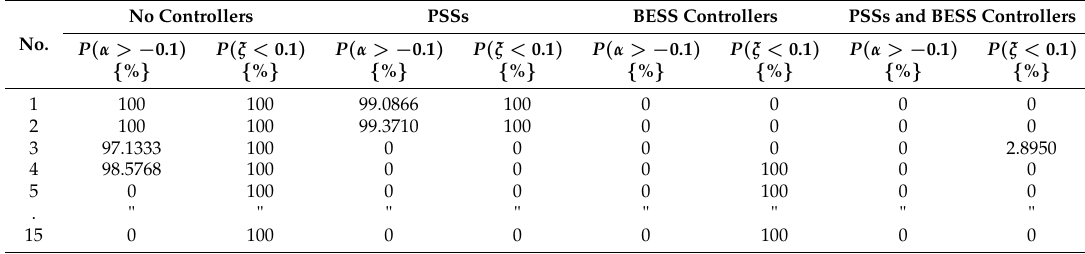
Table 10. Stability indices under different controller conditions for Scenario 2 using OBTM.